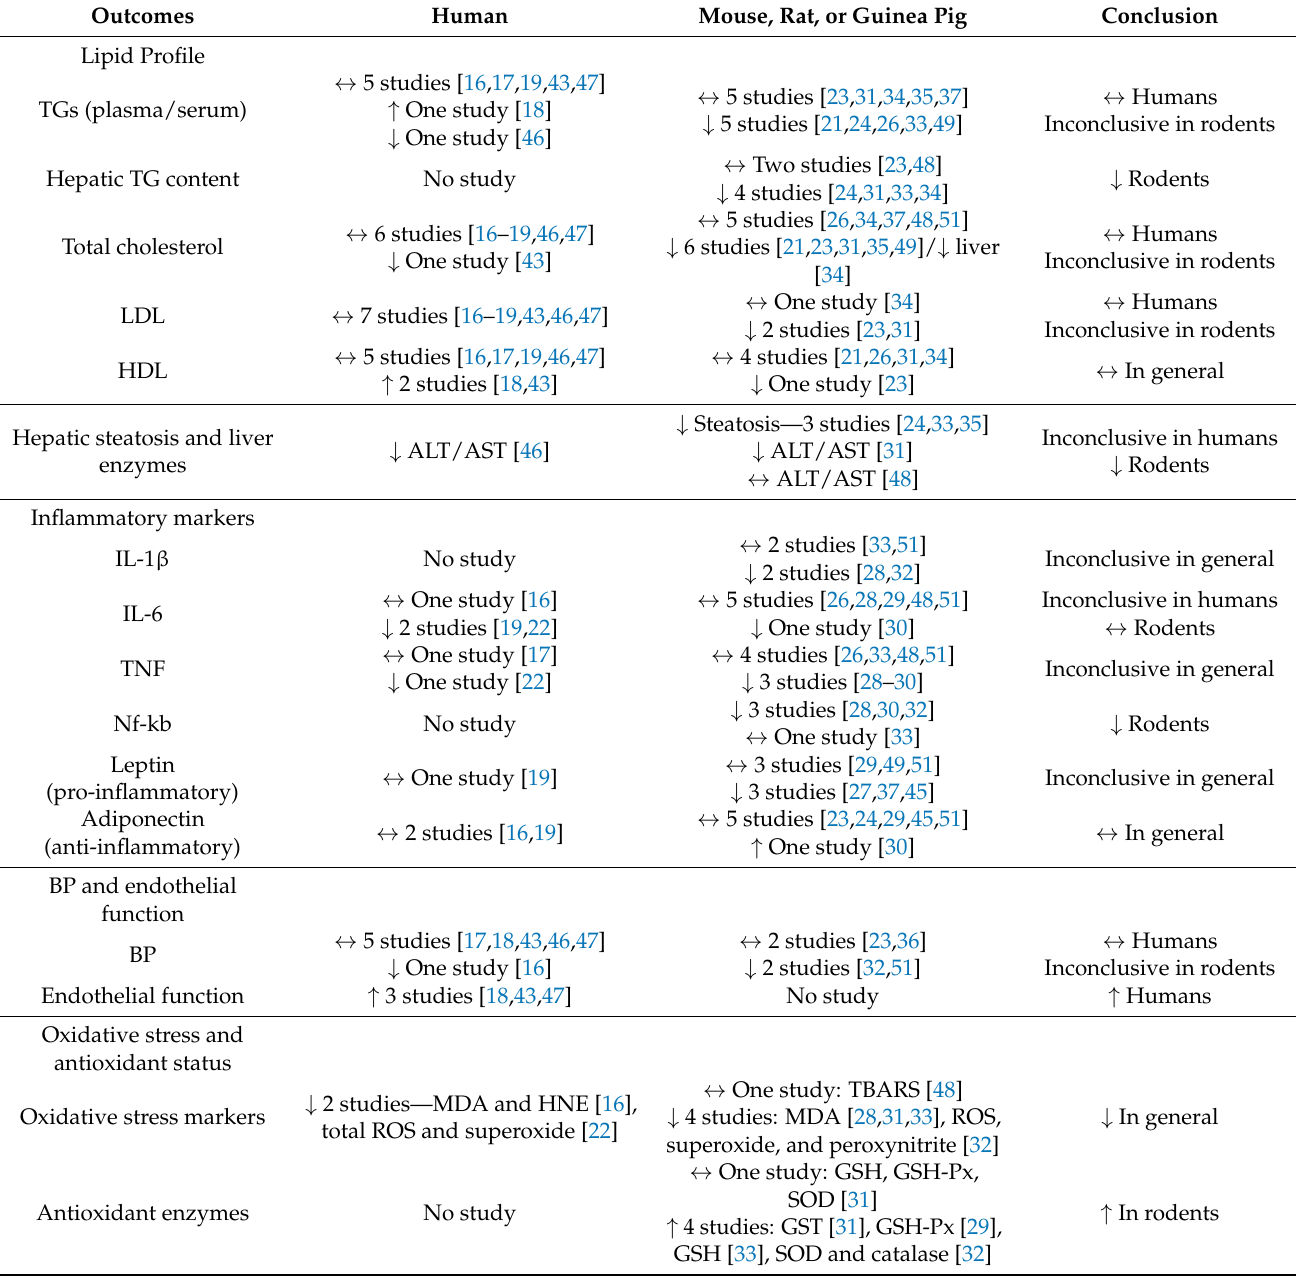
Table 2. Summary of the main results of studies that have evaluated the effect of blueberry or bilberry consumption in obesity and related-metabolic parameters in human and